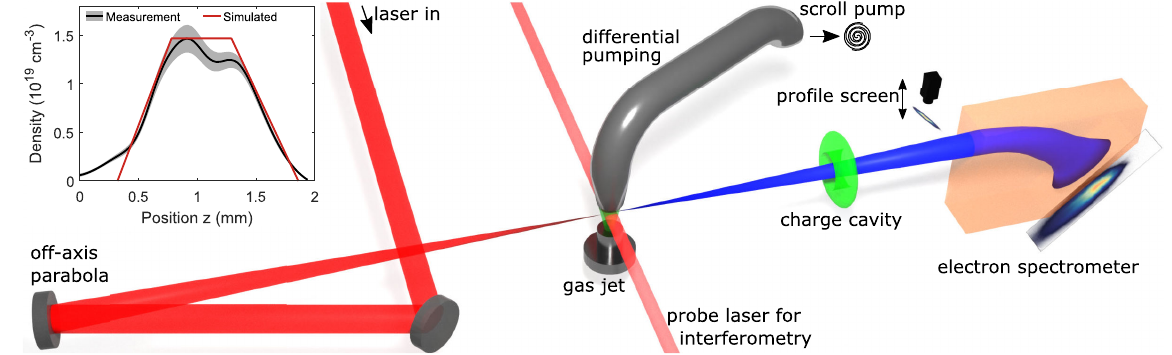
FIG. 1. Schematic of the experimental setup. Inset top left: measured plasma electron density (black), its rms deviation (grey shaded area) and the density profile used in the simulations (red